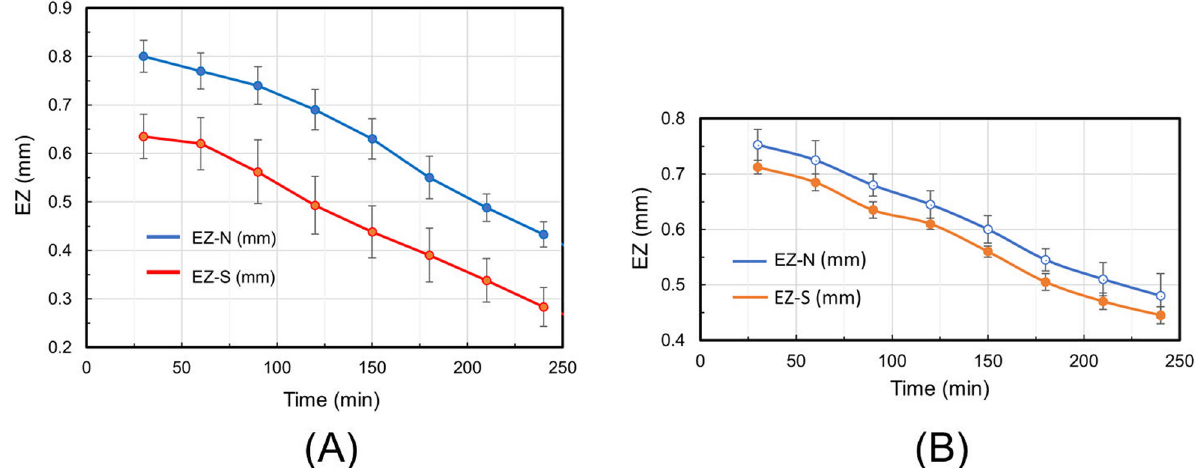
Fig 4. The time course of EZ size: A—PS microspheres; B—CPS microspheres. Error bars denote standard deviations. The differences between the averaged curves are statistically significant for PS microspheres ( p = 0.012) and not statistically significant ( p = 0.22) for CPS microspheres. The number of experiments, n = 3 (for PS and CPS